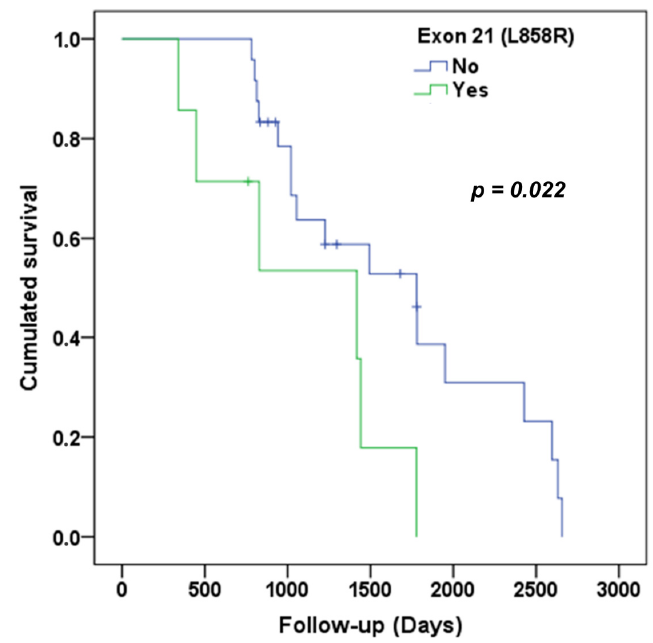
Figure 4. OS according to the presence or absence of the exon 21 mutation.